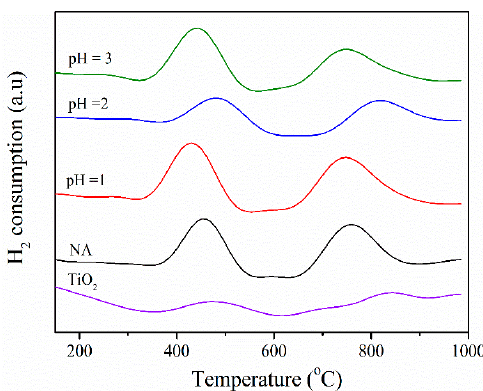
Figure 6. H 2 ‐ TPR profiles of catalysts on commercial TiO 2 and BFS ‐ TiO 2 made at different pH values of hydrolysis (2 wt. % V 2 O 5 , 5 wt. % WO 3 ).